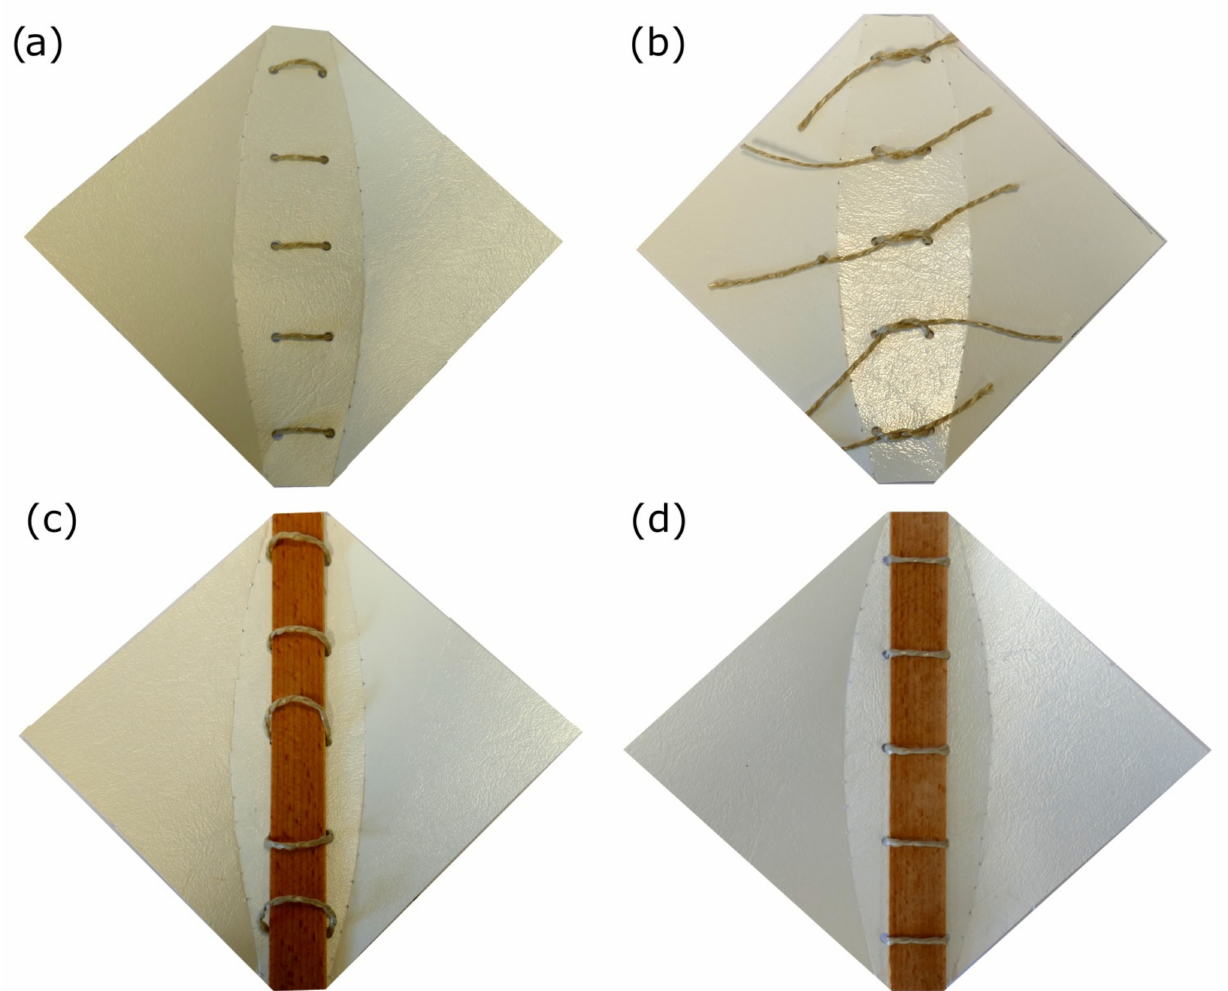
Figure 10. Various steps for connecting the Flectofold-like demonstrator to the actuating multilayer veneer composite. The five pieces of string are threaded through the adjacent large holes in the polymer sheet ( a ), and each is loosely knotted on the back of the demonstrator by an overhand knot ( b ). The wooden veneer is pushed through the string loops ( c ) and firmly attached to the polymer sheet ( d ) by tightening the overhand knots and then multiply knotting the strings with overhand knots on the back of the